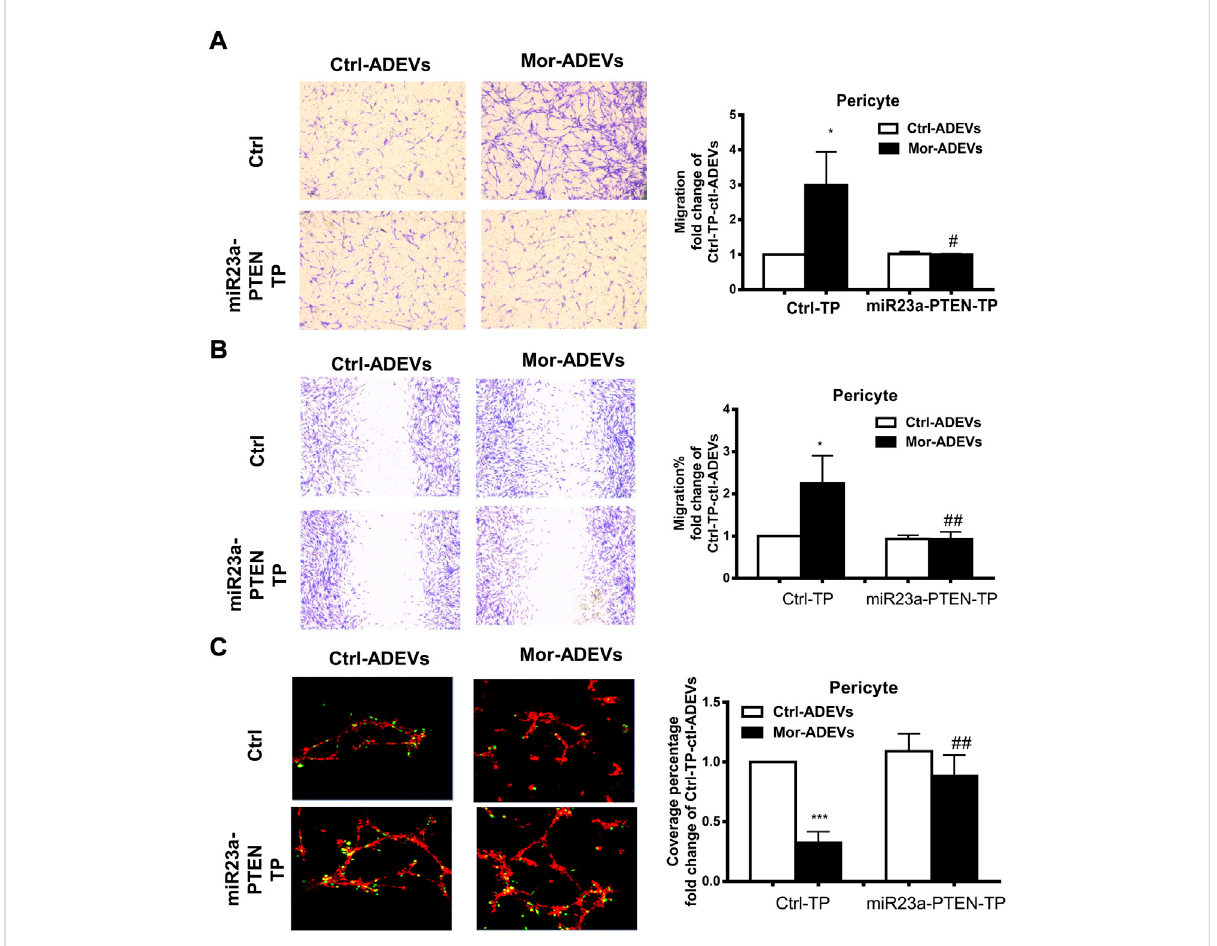
FIGURE 8 miR-23a-PTEN-TP attenuates morphine-ADEV-mediated pericyte migration. (A – C) Pericytes were transfected with either oligo of target protector control (CTL-TP) or miR-23a-PTEN-target protector (miR-23a-PTEN-TP) for 24 h, then exposed to either control-ADEVs or morphine- ADEVs. Then themigration ofpericyte wasmeasured bytranswell migration assay (A) . The representative imagesof migratory pericytes stained with crystal violet. Scale bar = 100 µm. The migration of pericyte was measured by the scratch assay (B) . The representative images of pericytes stained with crystal violet and then images were analyzed by ImageJ software. Scale bars, 100 μ m. Loss of pericyte was measured by 3D pericyte (green)-endothelia (Red) coculture model (C) , and then the representative images were analyzed by ImageJ. Scale bars, 50 μ m. All data are presented as mean ± SD,* p < 0.05,** p < 0.01, *** p < 0.001 vs. control group (CTL-TP-CTL-ADEVs), # p < 0.05, ## p < 0.01 vs. CTL-TP-morphine- ADEVs group using one-way ANOVA